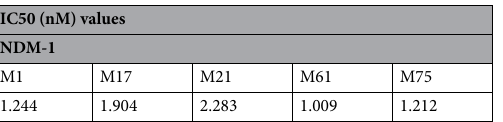
Table 5. Inhibitor concentration required to reduced 50% enzyme activity.